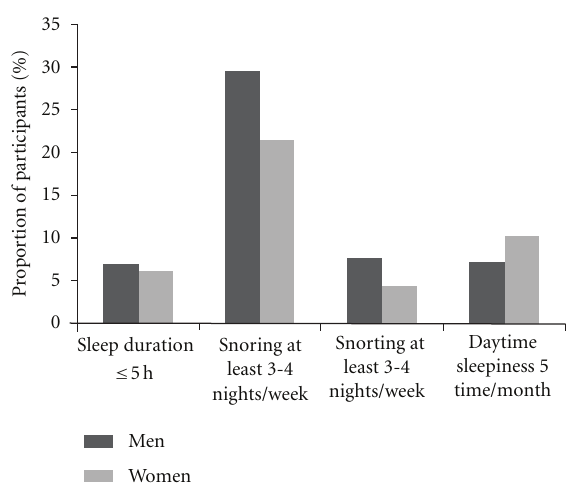
Figure 1: Proportion of participants by gender and by sleep